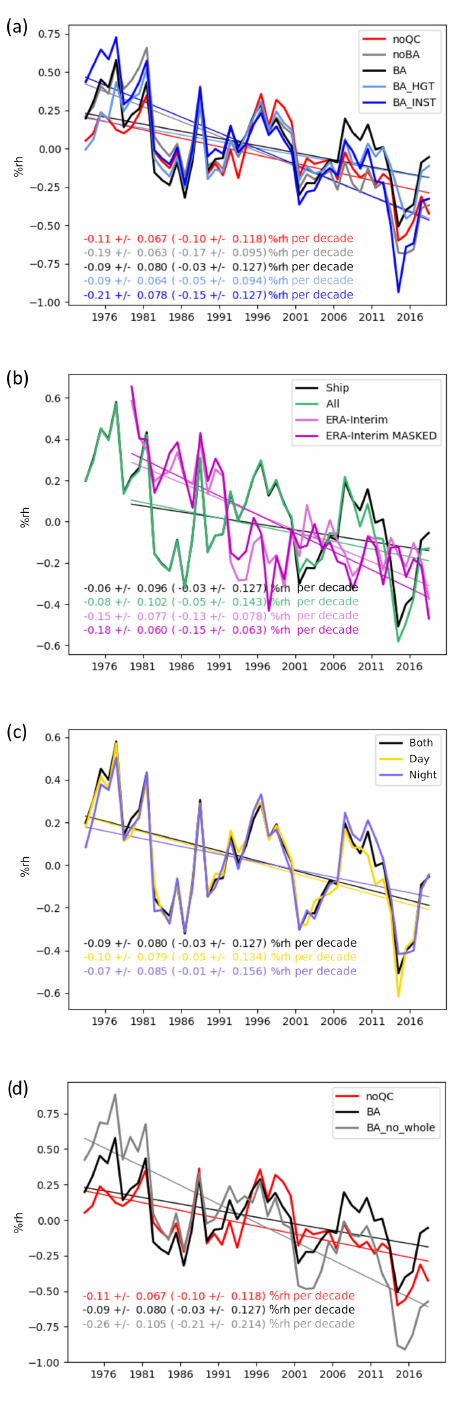
Figure 9. Global annual average anomaly time series and decadal trends ( ± 90% confidence interval) for relative humidity. See Fig. 8 caption for details. In addition, panel (d) shows the time series from the bias-adjusted data with removal of any data with a whole- number flag set (BA_no_whole). Trends in (b) cover the common 2018 period.